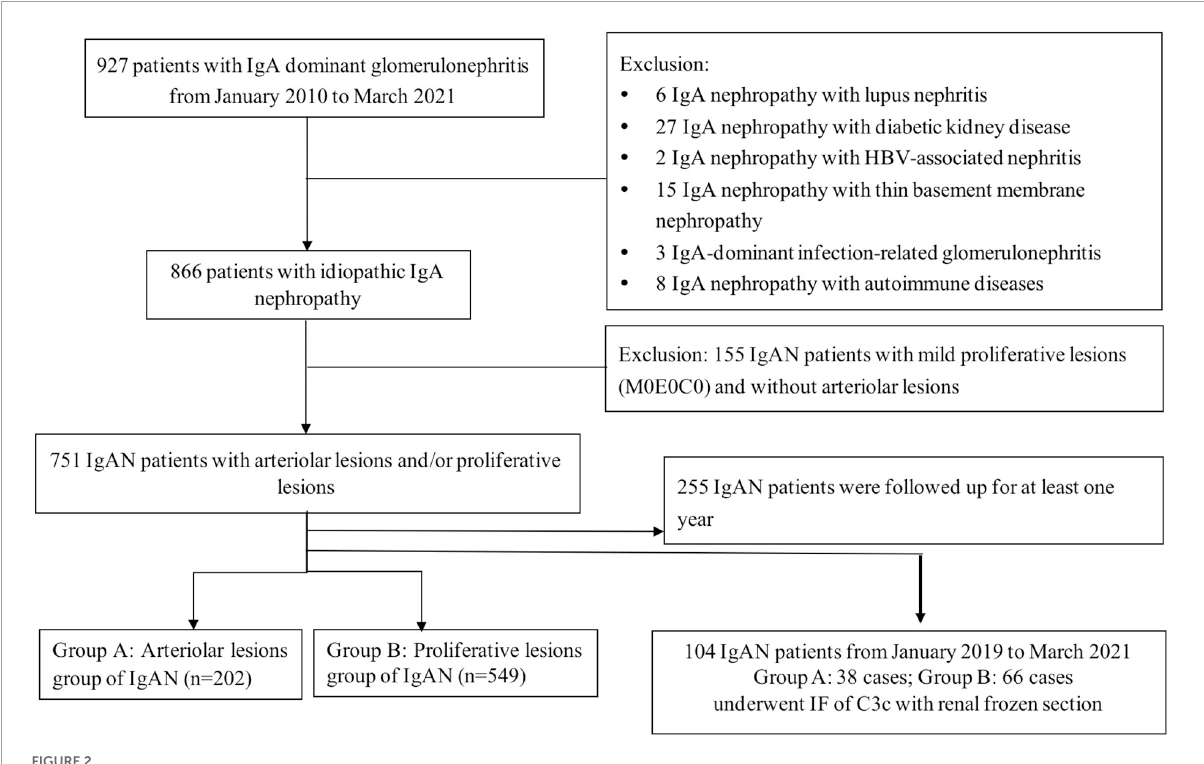
FIGURE2 Flow diagram of patients of IgA nephropathy enrolled in the study. A total of 866 patients with renal biopsy-proven IgAN diagnosed from January 2010 to April 2021. IgAN patients without intrarenal arteriolar lesions and proliferative lesions were excluded ( n = 115), the rest were divided into arteriolar lesions group (group A: n = 202) and proliferative lesions group (group B: n = 549). Among them, 255 patients were regularly followed up for at least 1 year. Among the enrolled patients ( n = 751, group A and group B), frozen renal biopsies of 104 patients from January 2019 to March 2021 were enrolled for immunofluorescence of